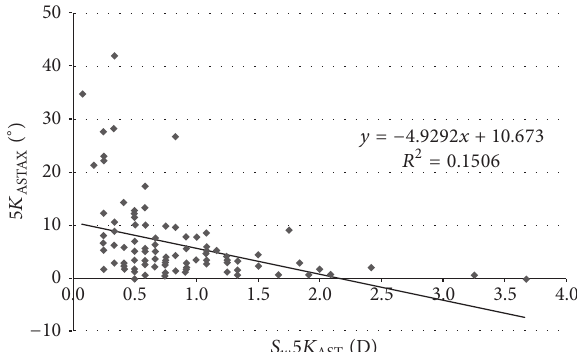
Figure 4: Scatterplot showing the relationship among the mean magnitude of corneal astigmatism in the 5 mm central zone ( 5𝐾 AST ) and the within-subject standard deviation ( 𝑆 𝑤 ) associated with the axis of such corneal astigmatism ( 5𝐾 ASTAX ). The adjusting line of data obtained by means of the least-squares fit is displayed.